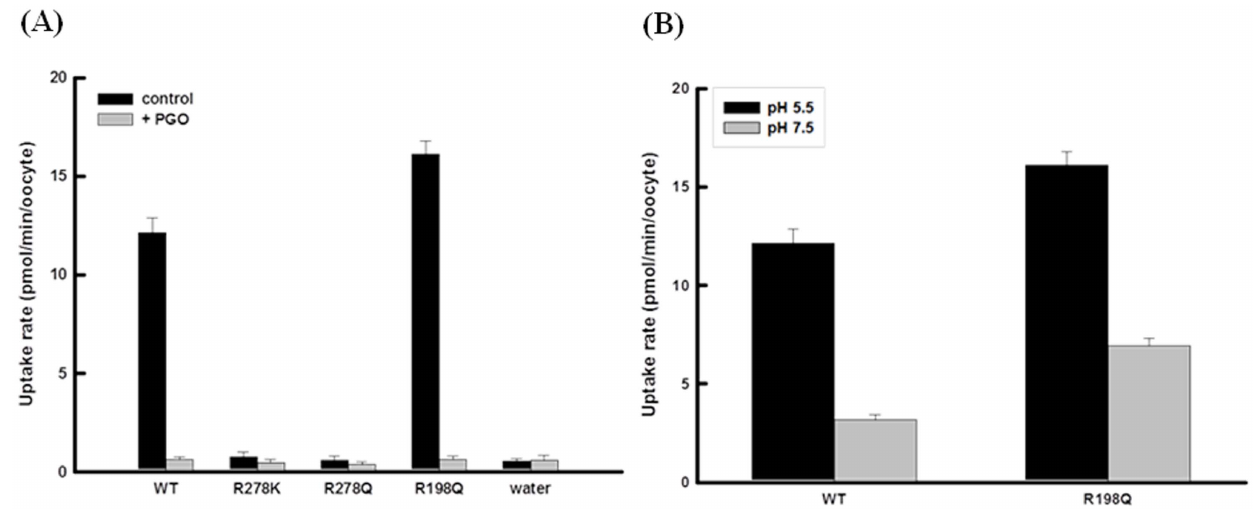
Figure 7. PGO effect and pH-dependency in hMCT4 mutants. (A) Uptake of 0.1 mM L-lactate was measured before and after treatment with 100 mM PGO in oocytes injected with hMCT4-WT or the indicated mutants. Data are presented as means 6 S.E. of three – five experiments. (B) Uptake of L-lactate was measured in hMCT4-WT or -R198Q expressing oocytes with 10 min incubation in transport buffer of pH 5.5 or pH 7.5 in the presence of 0.1 mM L-lactate. Data are presented as means 6 S.E. of four – five experiments.